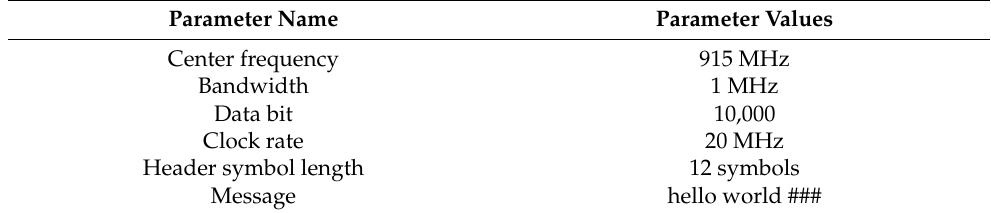
Figure 11. SDR performance evaluation experiment set-up. Table 1. SDR configuration parameters.